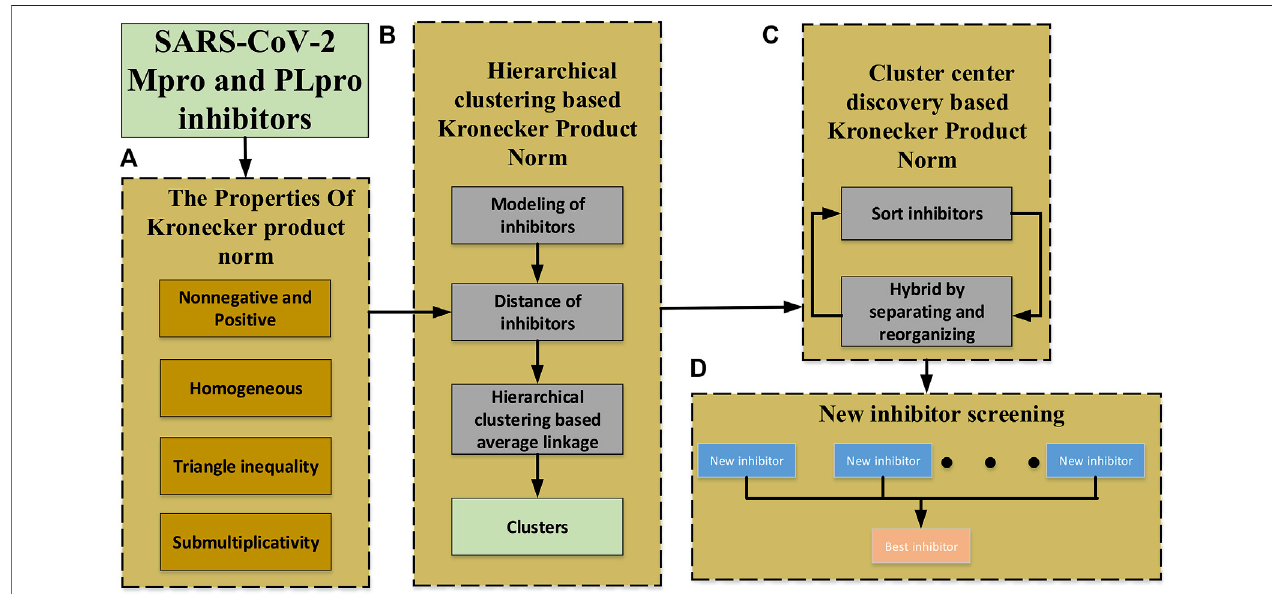
FIGURE 2 | Schematic diagram of the proposed approach. (A) The de fi nition of Kronecker product ( p , m )-norm and its properties. (B) The clustering of non- equidimensional inhibitors based on Kronecker product ( p , m )-norm and hierarchical clustering. (C) The cluster center generating based on the Kronecker product ( p , m )-norm to get much newer inhibitors. (D) New inhibitors screening to fi nd the best inhibitor.